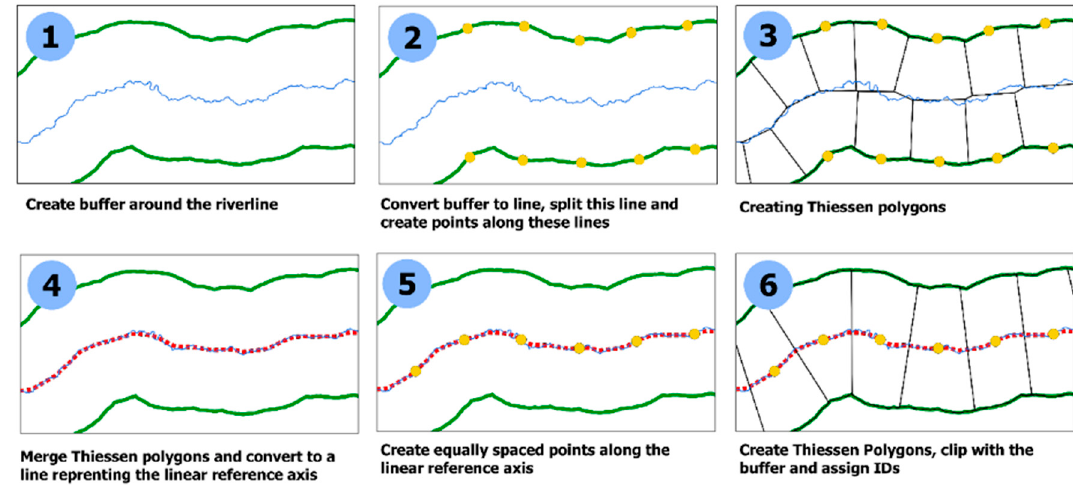
Figure 3. Framework for river corridor disaggregation (based on Alber and Piégay [30]); Please refer to the text for further explanation.